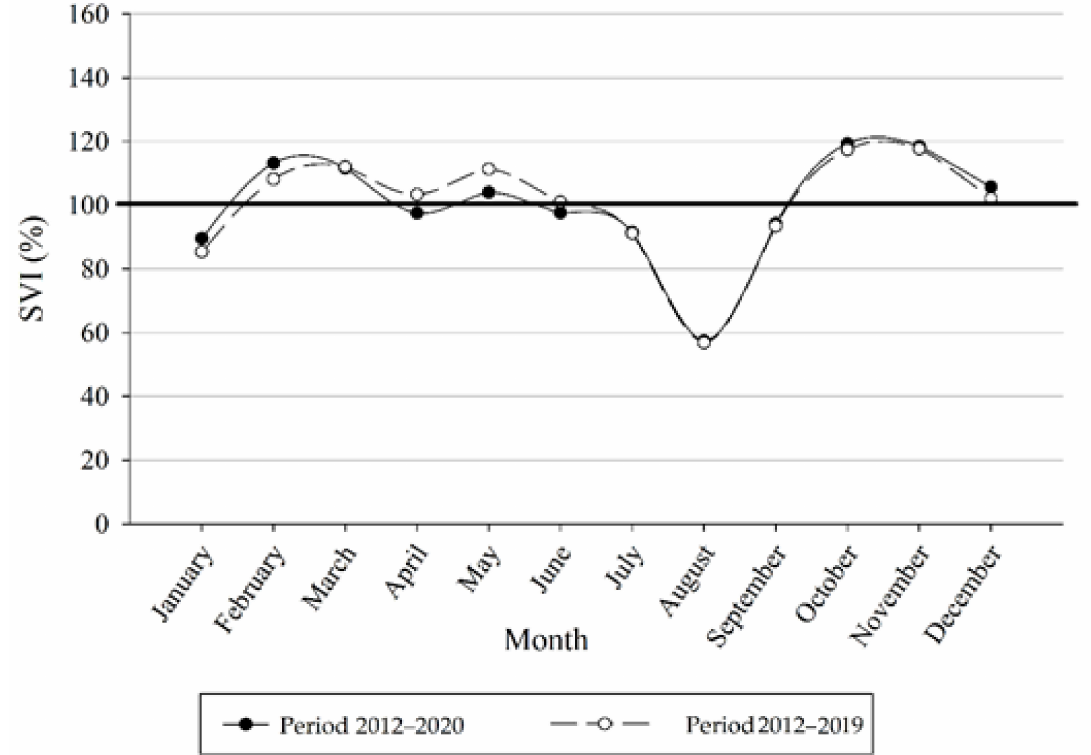
Figure 19. Seasonality pattern of vehicle disembarking traffic of the port of Valencia during the periods 2012–2019